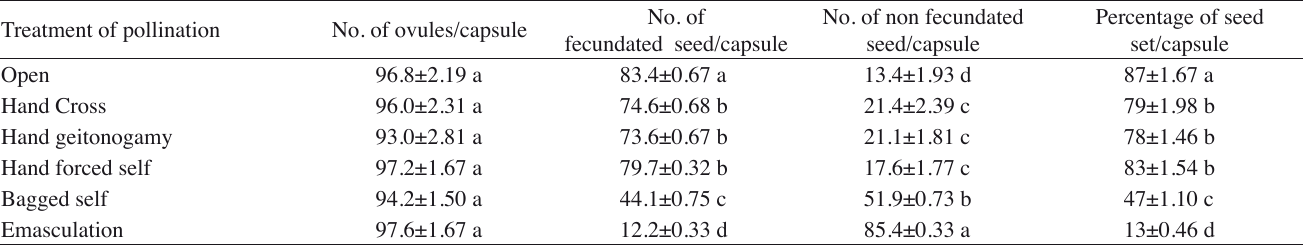
Table 3 - Seeds set after different pollination treatment in Nigella sativa location A. Season two Treatment of pollination